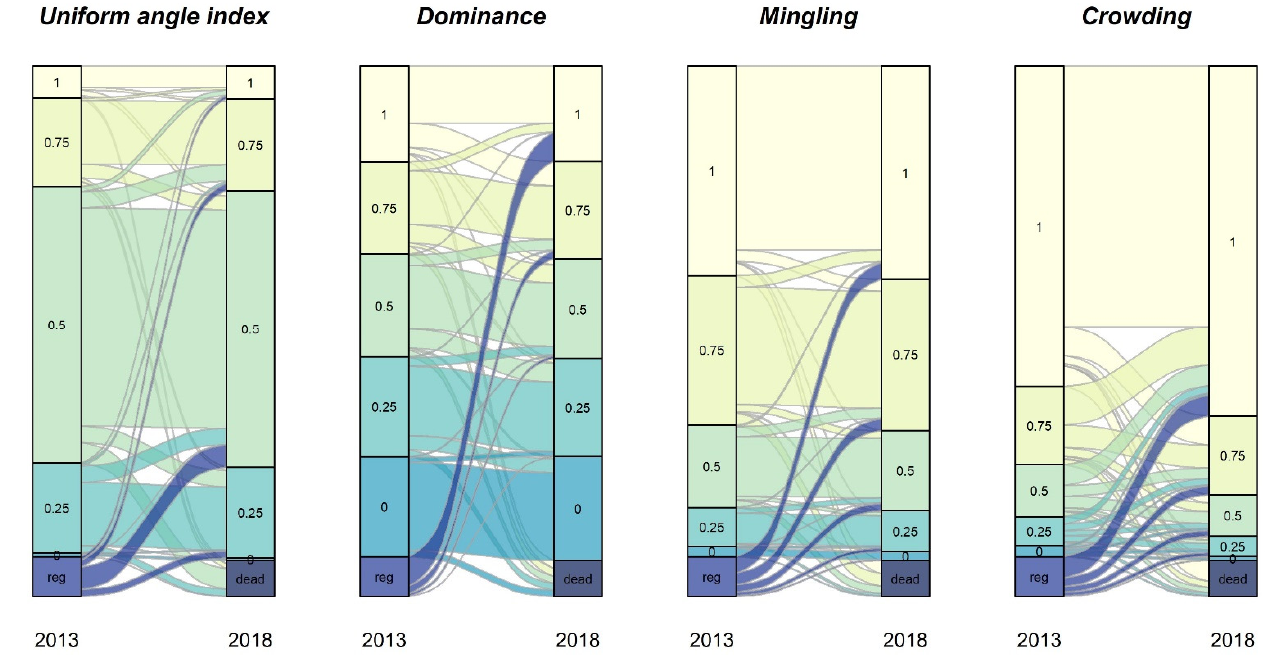
Figure 4. Changes in values distribution of different stand spatial structural parameters from 2013 to 2018 of all three plots. The “reg” means the regeneration in 2013 and growing into a living tree (DBH ≥ 5 cm) in 2018. The “dead” means the living trees in 2013, that have died in 2018. The flows in the figure connect the structural attributes of trees between 2013 and 2018. Each flow represents a change type of structure attributes, and the width of the flow represents the relative proportion of this change type.